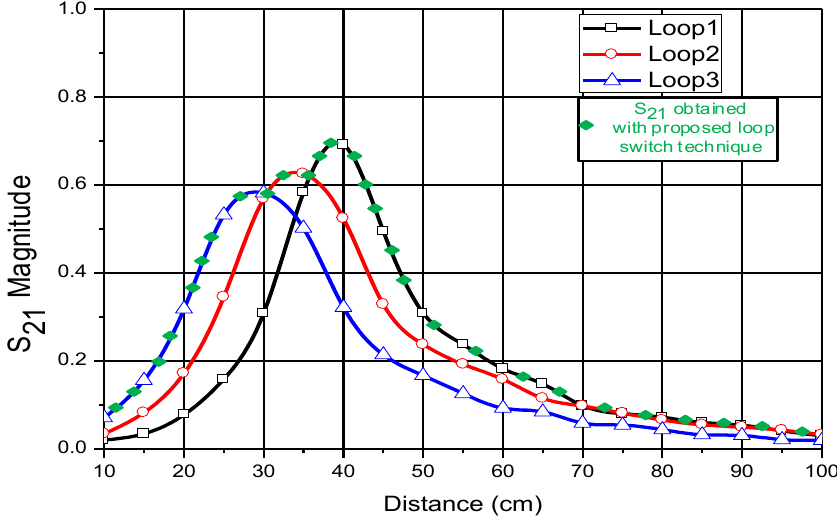
Figure 10. Measured S 21 magnitude using a vector network analyzer (VNA) for different loops with varying d 23 in the Case 1